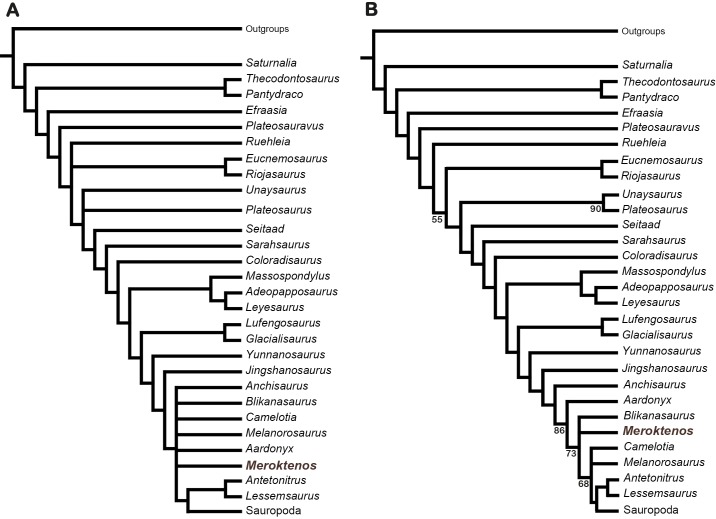
Phylogenetic position of Meroktenos based on the data set available from Apaldetti et al. (2014).(A) Strict consensus of the 440 most parsimonious trees (L = 1,308 steps). (B) Majority-rule consensus of the 440 most parsimonious trees. Sauropoda sensu Salgado, Coria & Calvo, (1997) (Peyre de Fabrègues, Allain & Barriel, 2015).